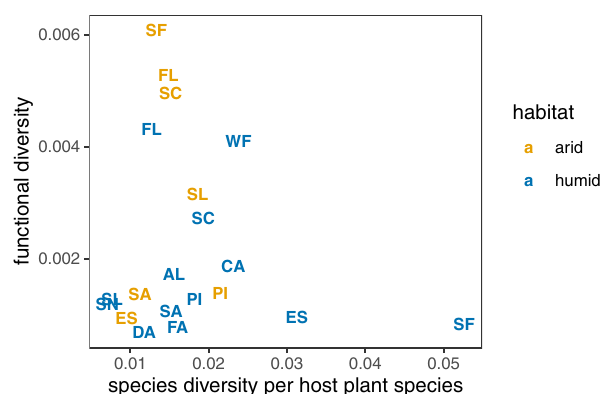
Fig. 5 Functional diversity plotted against species diversity, for the land snail communities on the Galápagos Islands. Species diversity is normalized by the number of host plant species in each sub-community, to get a better index of species diversity relative to the number of available ecological opportunities. Labels are island name abbreviations: Alcedo Volcano (AL), Cerro Azul Volcano (CA), Darwin Volcano (DA), Espanola (ES), Fernandina (FA), Floreana (FL), Pinzon (PI), Santiago (SA), Santa Cruz (SC), Santa Fe (SF), San Cristobal (SL), Sierra Negra Volcano (SN), and Wolf Volcano (WF). Colors represent communities in the arid (yellow) and humid (blue) zones of the islands, which form independent subcommunities ( n = 20 independent samples). The data do not support a positive relationship between species- and functional diversity. (A linear regression has slope − 0.03 ± 0.04 with p = 0.53; however, since the data are heteroscedastic and the expected patterns from our model as shown in Fig. 3 are not linear, to begin with, any such statistic should be treated as just an illustration.) The lack of a positive trend is retained even if one does not normalize species diversity with the number of host plant species (Supplementary Figure 14). Furthermore, a negative slope is retained in >90% of cases after randomizing the number of sampled individuals (Supplementary Note 7.2). This means that the results are robust against measurement error in relative abundances. [Further statistical information on the regression: p value based on two-sided t test; no correction for multiple